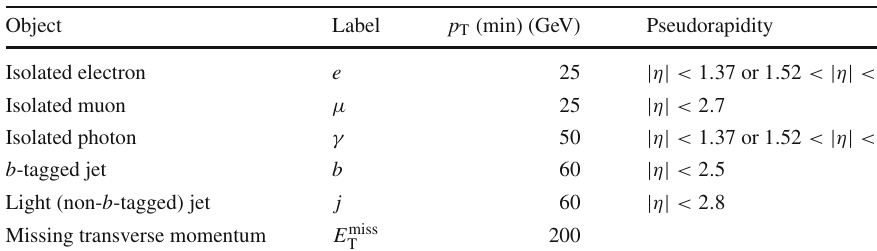
Fig. 2 Flow diagram for the trigger and offline event selection strategy. The offline requirements are shown on the left of the dashed line and the trigger requirements are shown on the right of the dashed